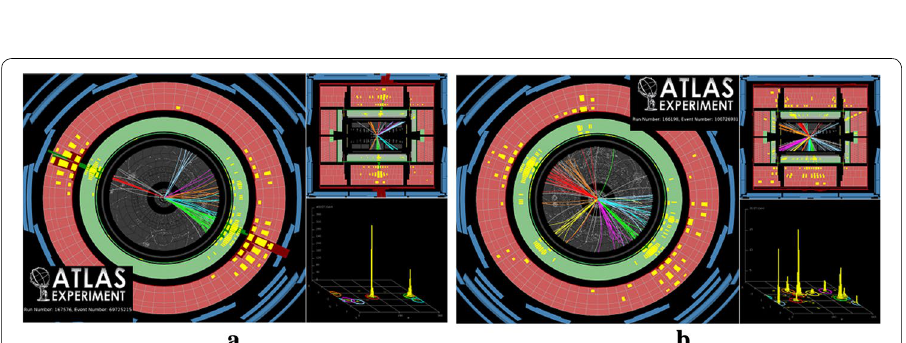
depicted by the subtle purple and orange dots, respectively. The Neutralinos and the Charginos signal events as depicted in b needs to be extracted from the background Top quark decay events using the BDT